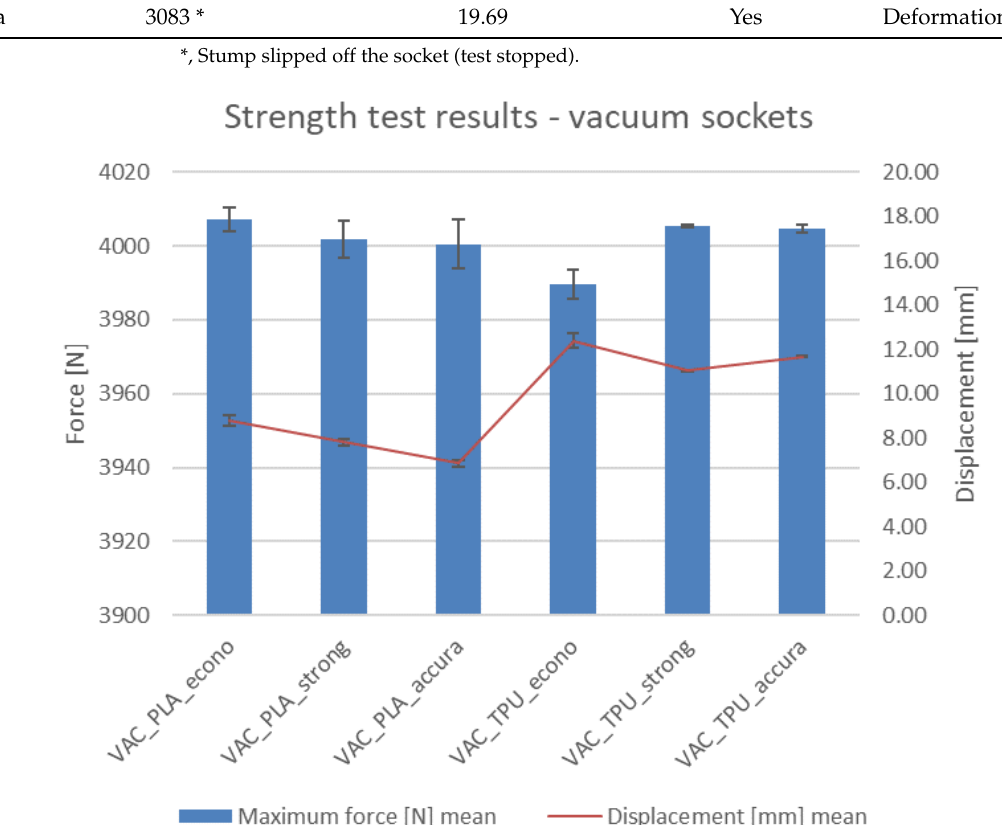
Figure 20. Strength test results for the Velcro sockets. As mentioned in the methodology, the test was conducted until reaching 4 kN of force or until fracture and/or visible deformation occurred. An additional condition was the socket slipping off the stump without any sign of failure (possible only for the VEL sockets due to their semi-open geometry). This occurred for all the samples in group 11 and 12, which are Velcro sockets made of TPE, produced in the strong and accura strate- gies. This did not happen to the sockets manufactured using the econo strategy.